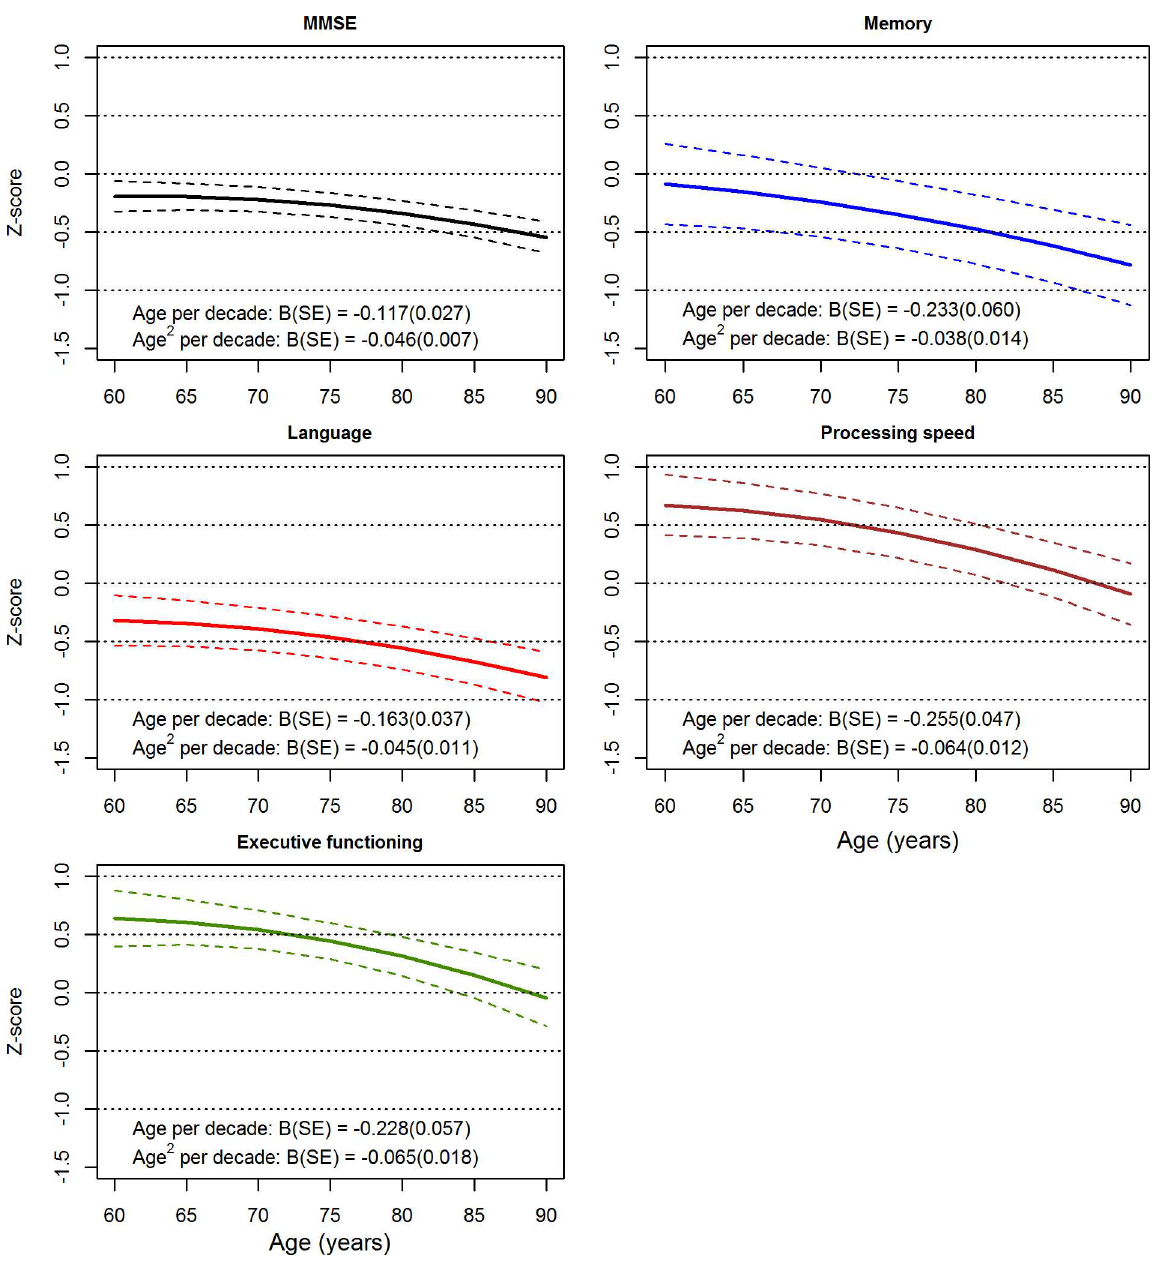
Fig 2. Longitudinal variation with age for the Mini-Mental State Examination (MMSE) and cognitive domains. Results were calculatedfrom pooledestimates of the fixed effects of age and age 2 , adjusted for sex and education. Dashedlines indicate95% confidence